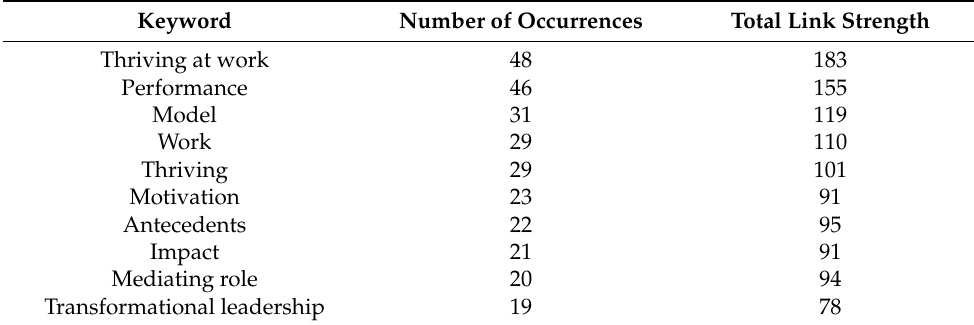
Table 11. The most popular keywords in the topic of thriving at work.